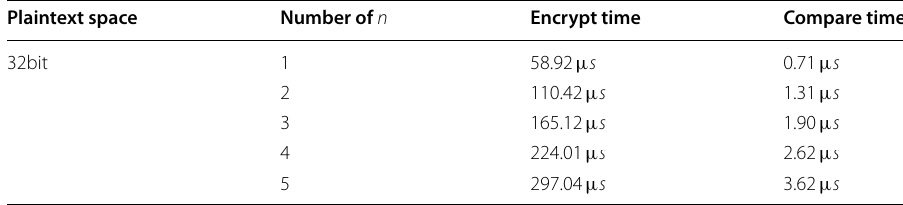
Table 3 The time cost of encrypt and compare phase Plaintext